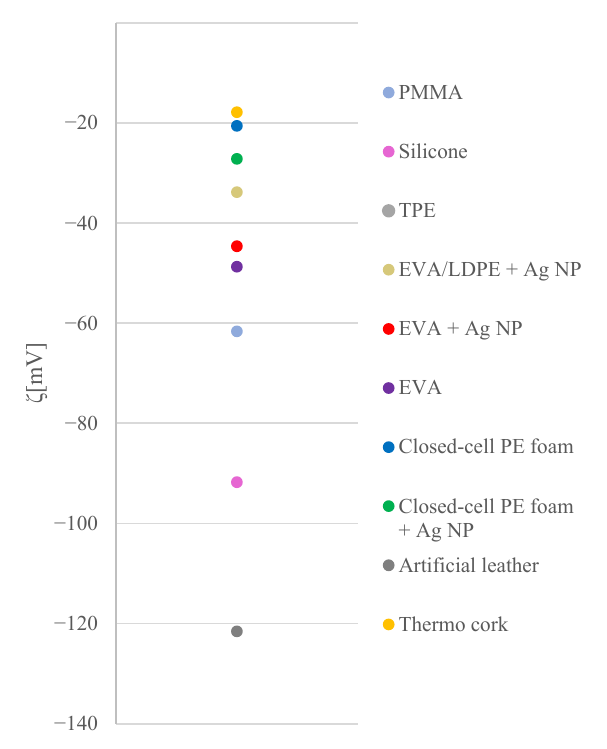
Figure 4. Growth curves of S. epidermidis ( a ) and S. aureus ( b ) in nutrient broth. For S. epidermidis , colony ‐ forming unit per milliliter (CFU/mL) as a function of time is shown, whereas, for S. aureus , the time dependence of absorbance is presented [26]. Reprinted with permission from [26]. Copyright © 2014 Elsevier.